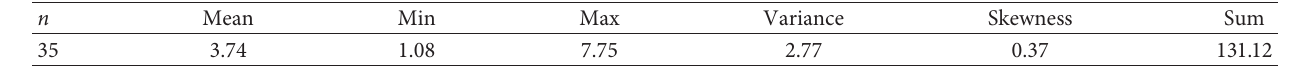
Table 5: The descriptive statistics of the values for ARW data, 1974–2008.